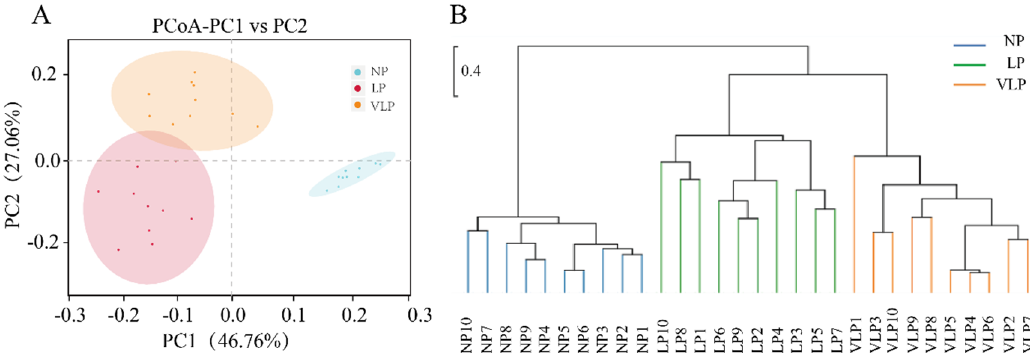
Figure 4. Comparison of gut bacterial community among NP, LP, and VLP. Principal coordinate analysis (PCoA) plot ( A ), UPGMA tree ( B ), all revealing significant differences among NP, LP, and VLP piglets based on the weighted unifrac distances of OTU community. NP = normal protein; LP = low-protein; VLP = very low-protein.